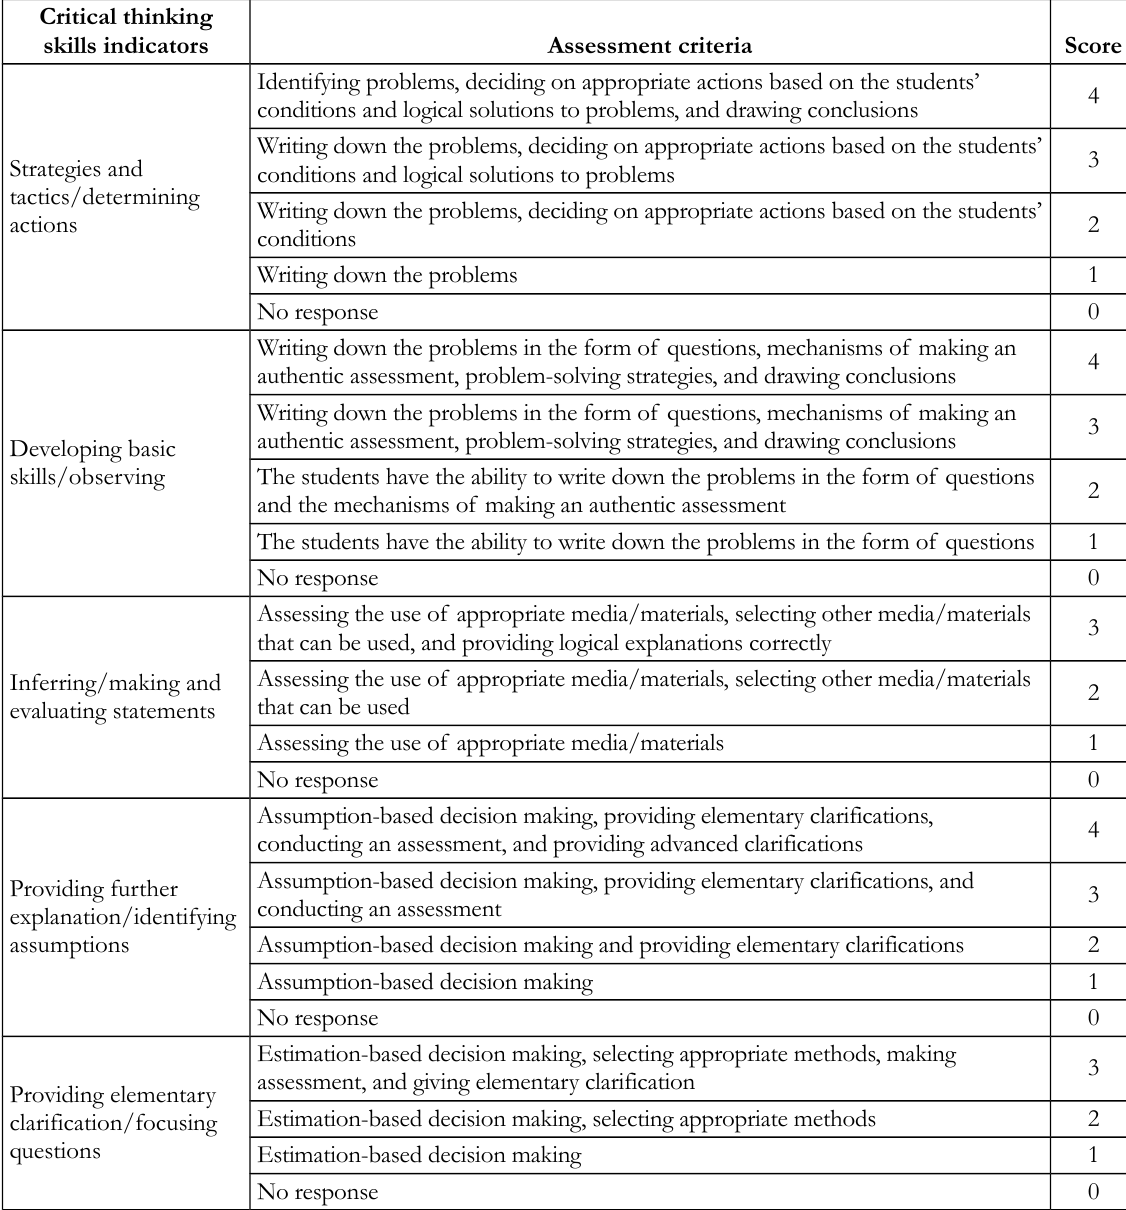
Table 3. Critical thinking skills assessment rubric in team project-based STEM-metacognitive skills learning (Ennis & Weir,